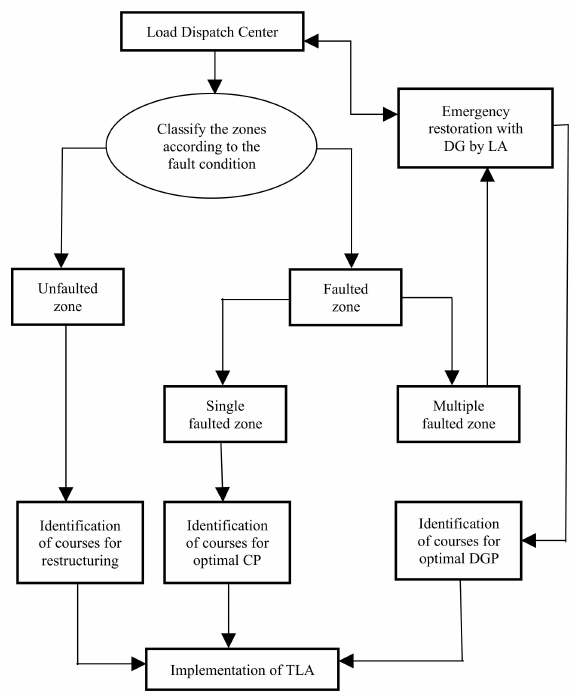
Figure 5. Optimization